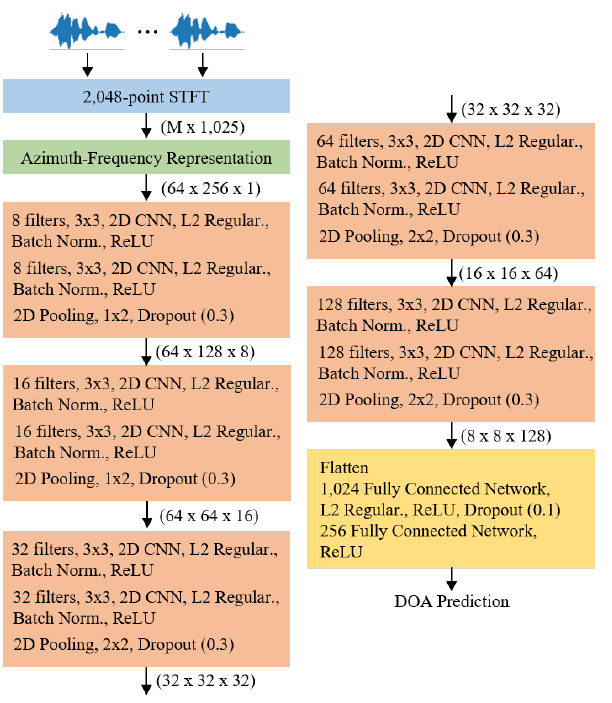
Figure 3. Convolutional neural network (CNN) architecture for sound